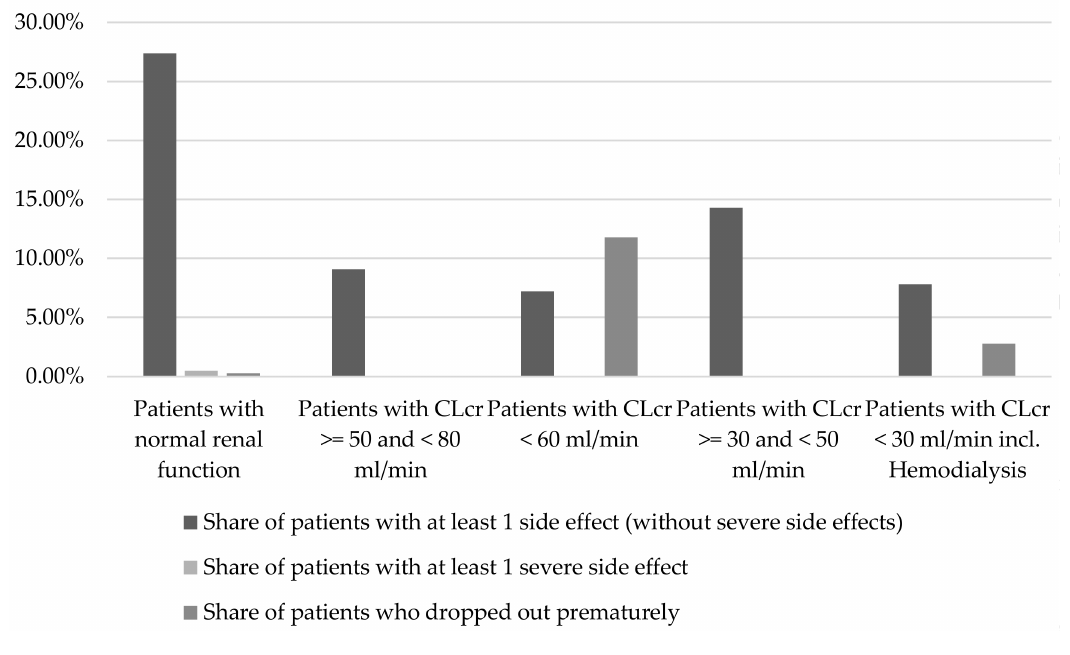
Figure 4. Occurrence of adverse events depending on renal function (n (patients with normal renal function) = 1812; n (patients with CLcr >= 50 and <80 mL/min) = 11; n (patients with CLcr <60 mL/min) = 610; n (patients with CLcr >=30 and <50 mL/min) = 35; n (patients with CLcr <30 mL/min incl. hemodialysis) = 399; per patient group (sorted by renal